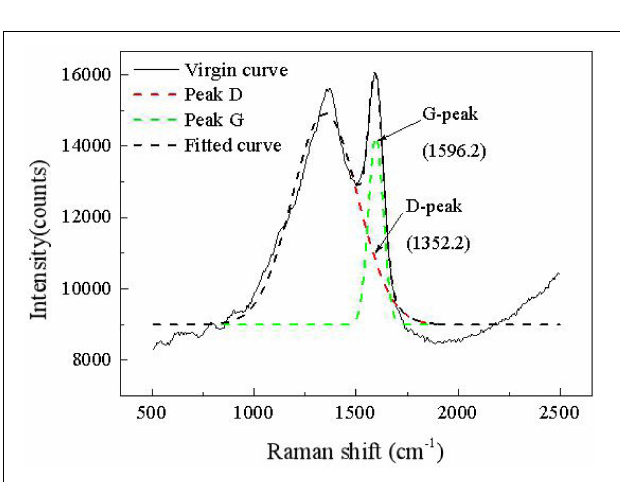
FIGURE 5 | Raman map of carbon deposition.